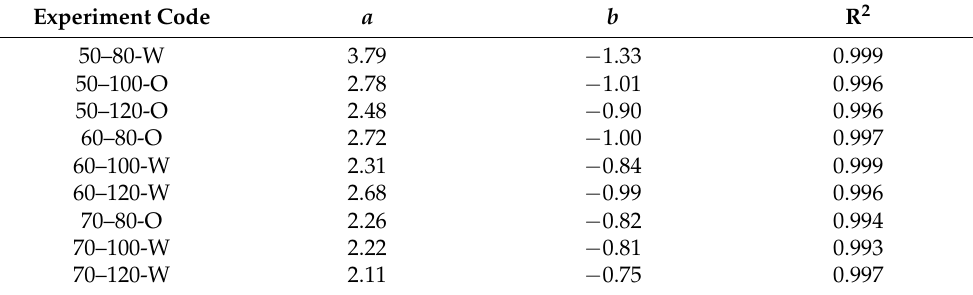
Table 3. Exponential fitting